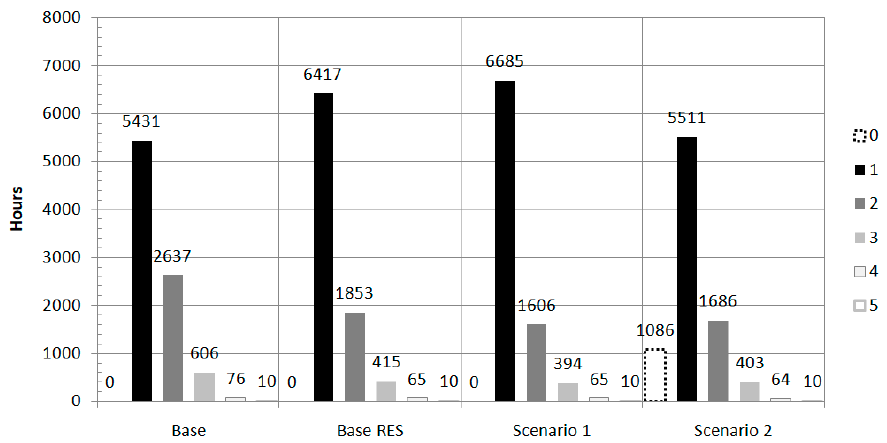
Figure 11. Number of annual duty hours per engine.